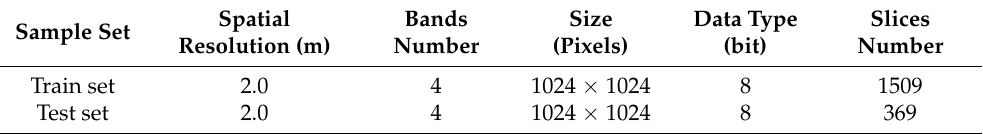
Table 2. Sample set information.